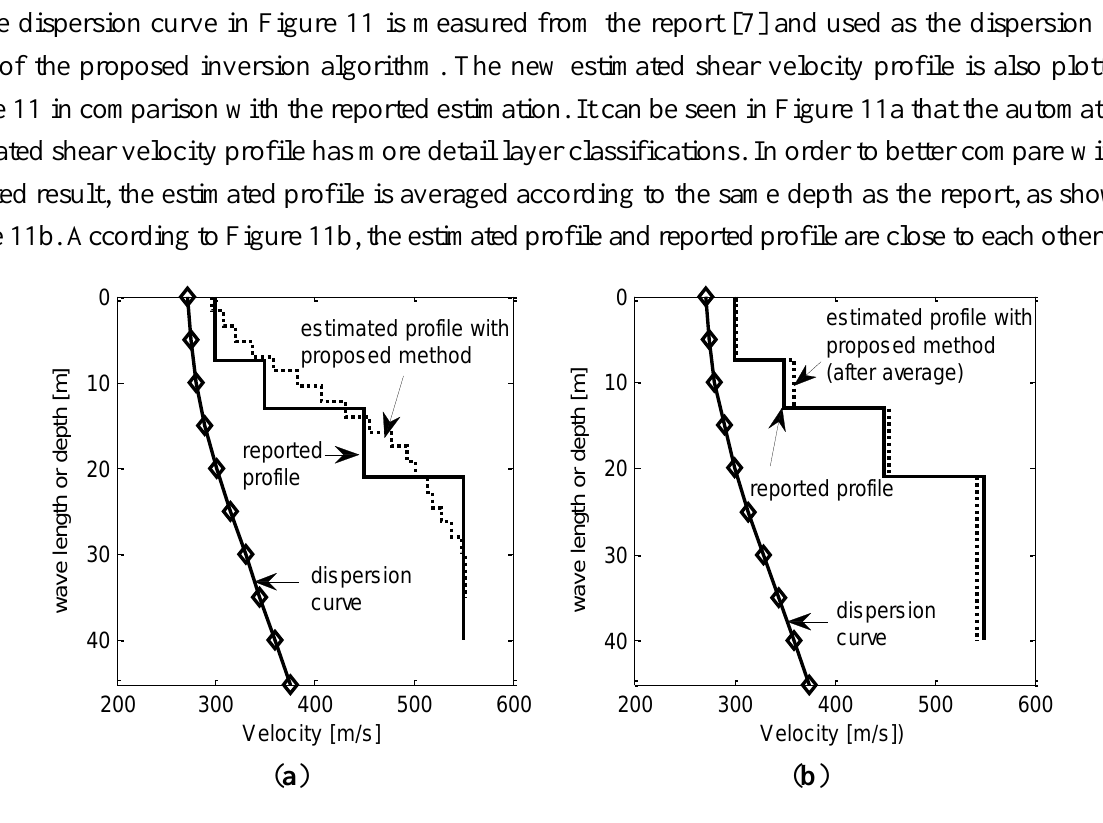
Figure 11. Estimated shear velocity profiles using the proposed inversion algorithm; ( a ) Automatically generated shear velocity profile; and ( b ) Averaged shear velocity profile. (The vertical axis scale is the wavelength for the dispersion curve and depth for